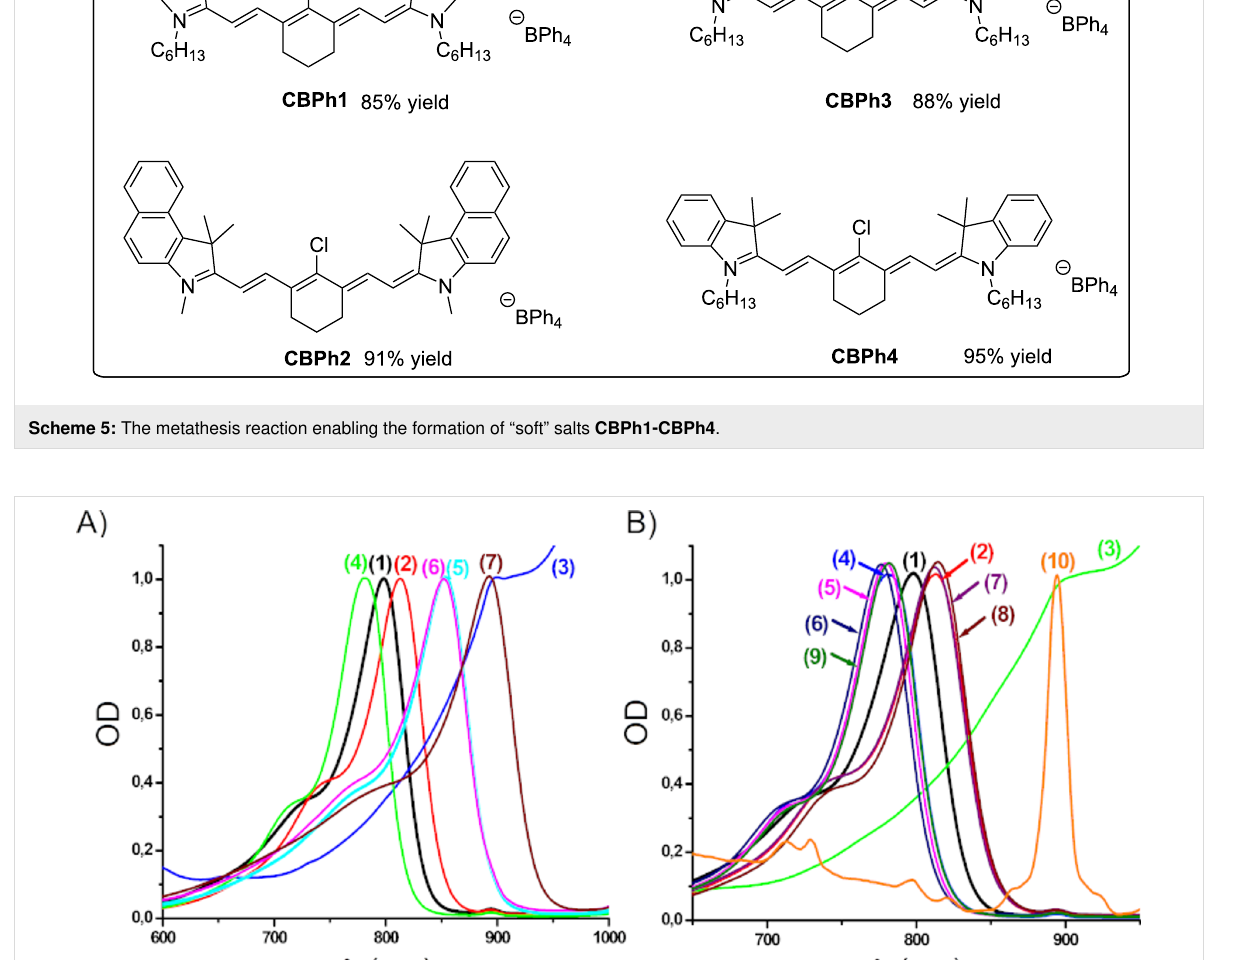
length of the irradiation used here. However, despite the low absorptions at 785 nm, the photopolymerization is still success-